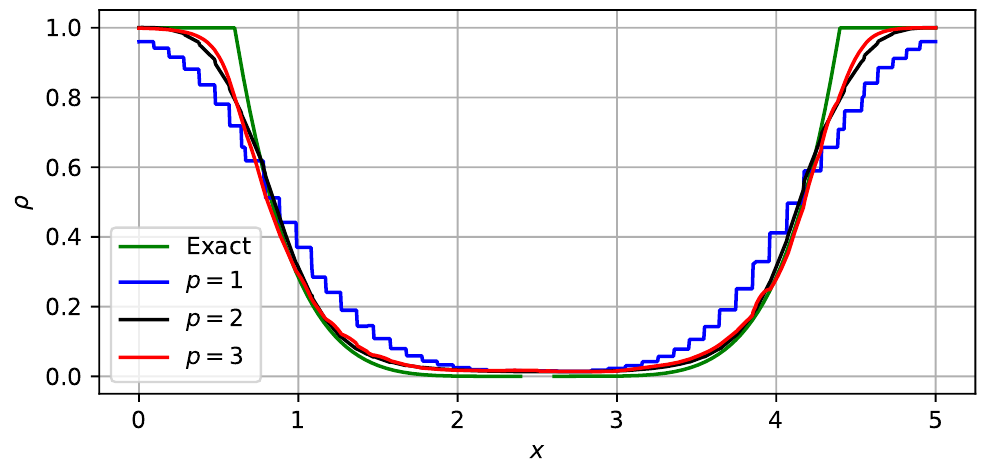
Figure 18. Comparison between solutions of ρ ( t = 0.3 ) in Problem